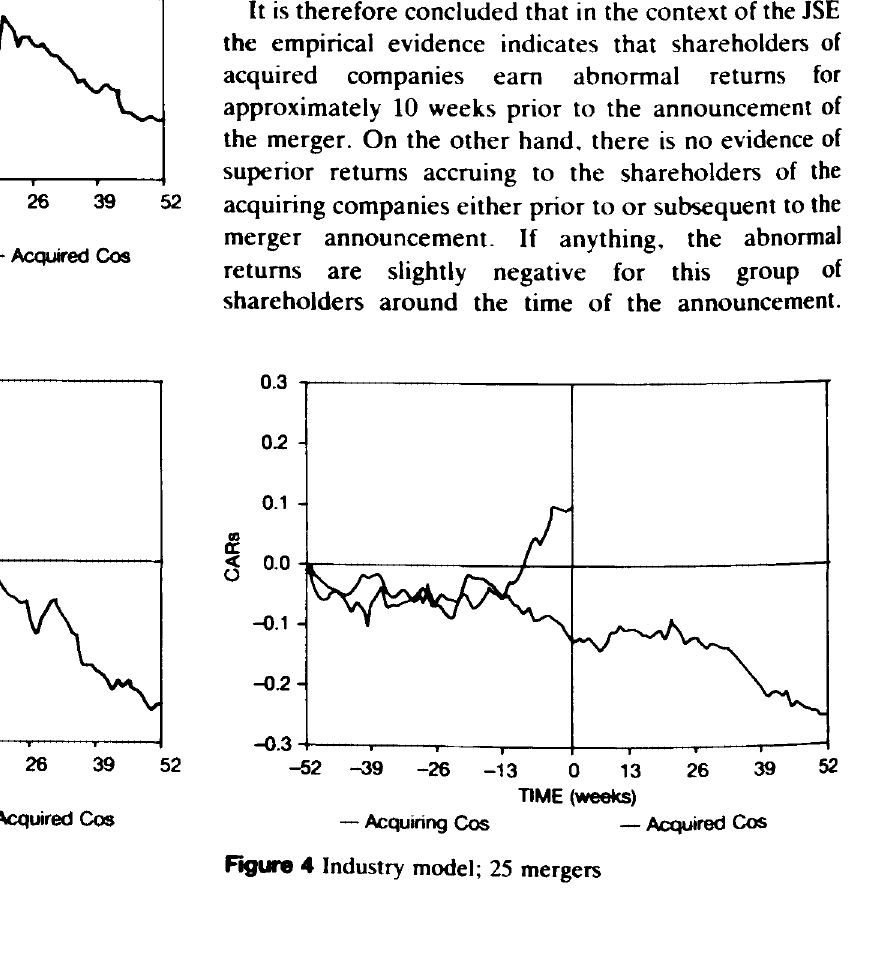
Figu'e 3 Market model; 8